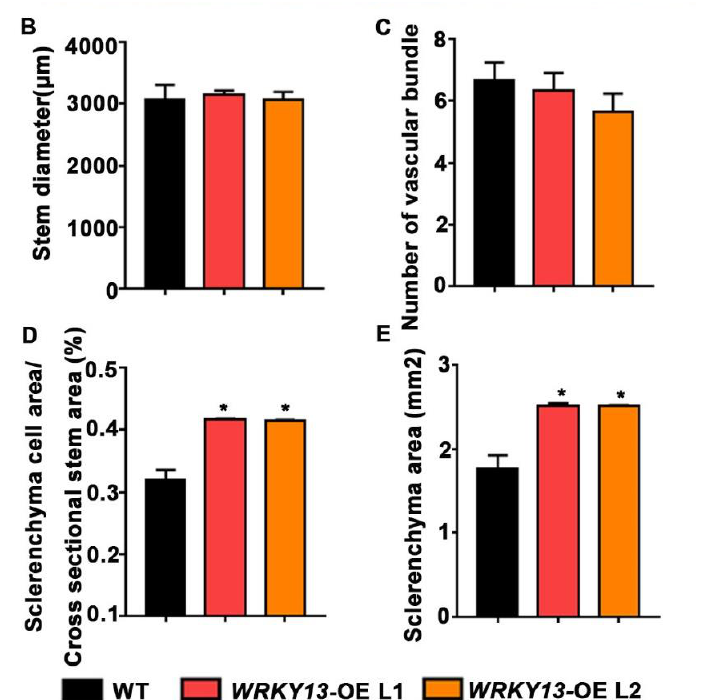
Figure 5. PtoWRKY13 overexpression promotes secondary cell wall (SCW) deposition in transgenic A. thaliana inflorescence stems. ( A ) Cross-sectioning and staining with Toluidine Blue of basal stems of 6-week-old WT and PtoWRKY13 -OE A. thaliana . ( B ) Stem diameter of WT and PtoWRKY13 -OE lines. ( C ) Number of vessel bundles in WT and PtoWRKY13 -OE lines. ( D ) Percentage of sclerenchyma cells in the stems of WT and PtoWRKY13 -OE lines. ( E ) Sclerenchyma area in the stems of WT and PtoWRKY13 -OE lines. (*, p < 0.05); ph, phloem; xf, xylem fiber; ve, vessel; if, interfascicular fiber. Scale bars: ( A ) 100 μm.